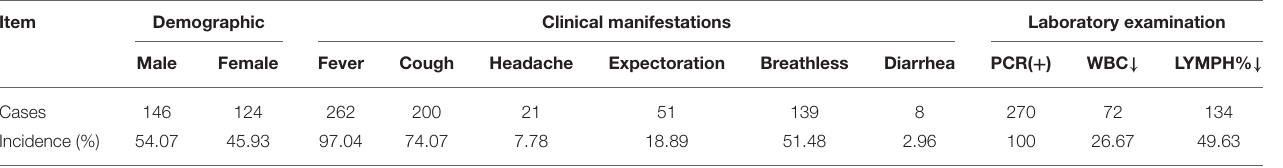
TABLE 1 | General